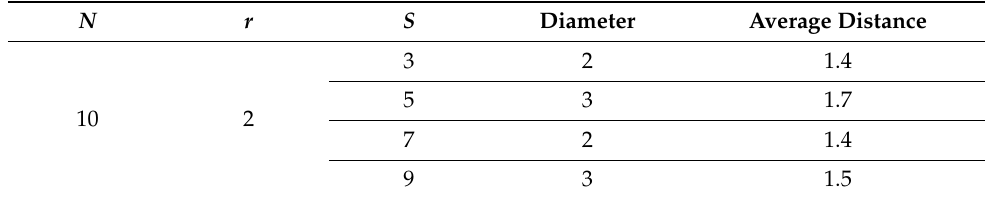
Table 2. Diameter and Average Distance of G ( 10; ± 2, ± s )